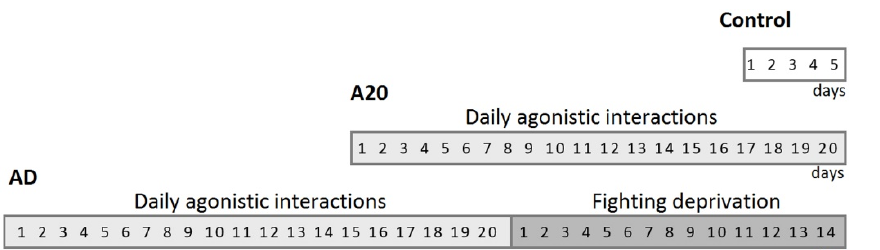
Figure 9. Graphical representation of the experiment. A20: males with consecutive 20 days of wins in daily agonistic interactions; AD: the A20 mice after subsequent 14 days of fighting deprivation; Control: mice without the experience of agonistic interactions. Control males were housed one per cage for 5 days, which enabled them to feel dominant and potentially able to demonstrate aggressive behavior in a conflict situation.